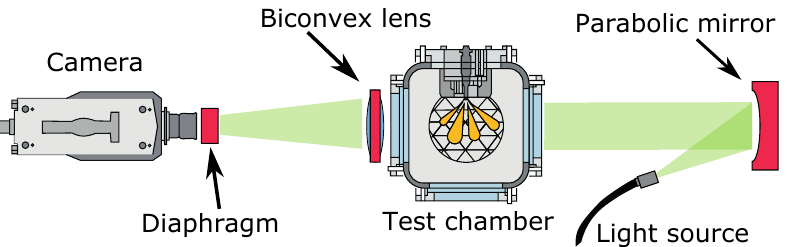
Figure 4. Schlieren optical setup for liquid phase